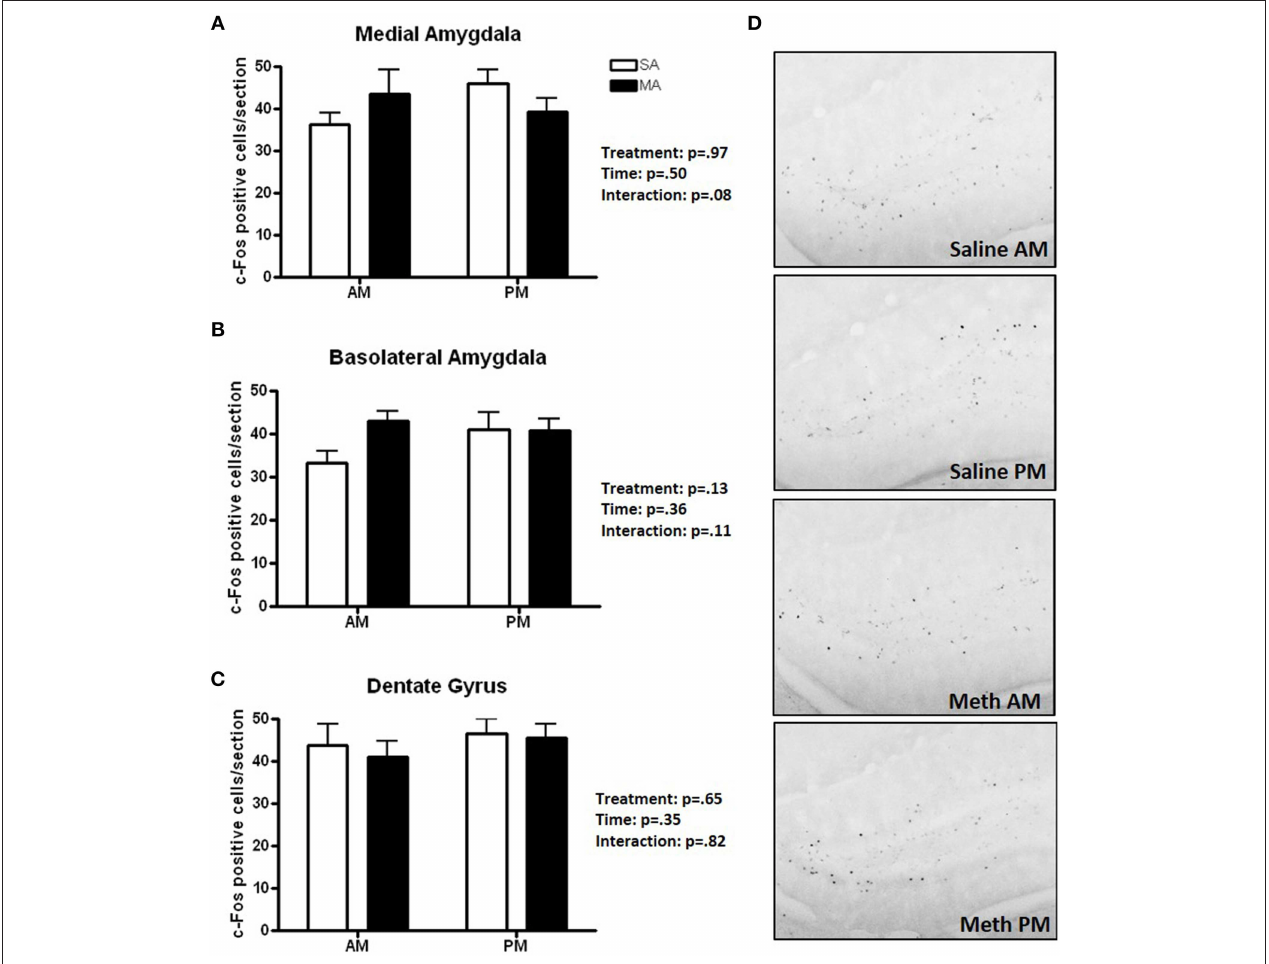
FIGURE 5 | Brain areas that showed no treatment or time effects or a treatment × time interaction. There were no significant effects of MA, time, or an interaction between MA and time in the MEA (A) , BLA (B) , and DG (C) . There was a trend toward an interaction in the MEA ( p = 0.08 ) but that did not reach significance. Representative images for neuronal activation in the DG following saline or MA exposure in the day and night are shown in (D) . n = 10 mice/treatment/time